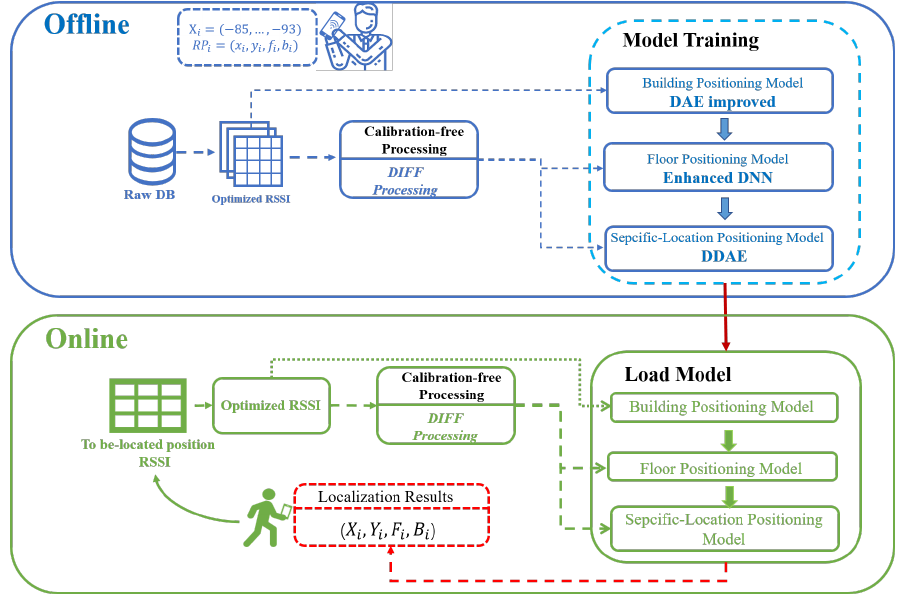
Figure 1. System